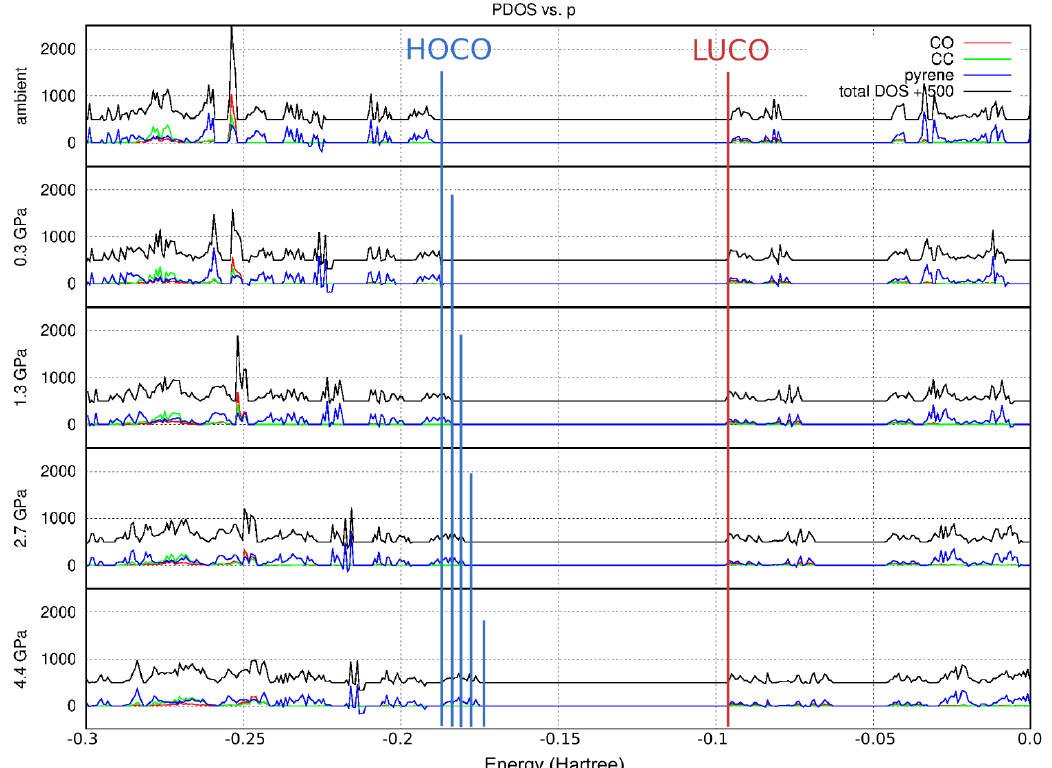
Figure 7. Electronic Partial Density Of State (PDOS) plots in the vicinity of the band gap theoretically calculated for crystalline 1a . Shrinking of the band gap with pressure is clearly visible. The highest occupied energy band is dominated by contributions from the pyrene moiety (blue), while a small contribution from the C=O (red) and C ≡ C (green) fragments is visible in addition to that of pyrene at the lowest unoccupied energy